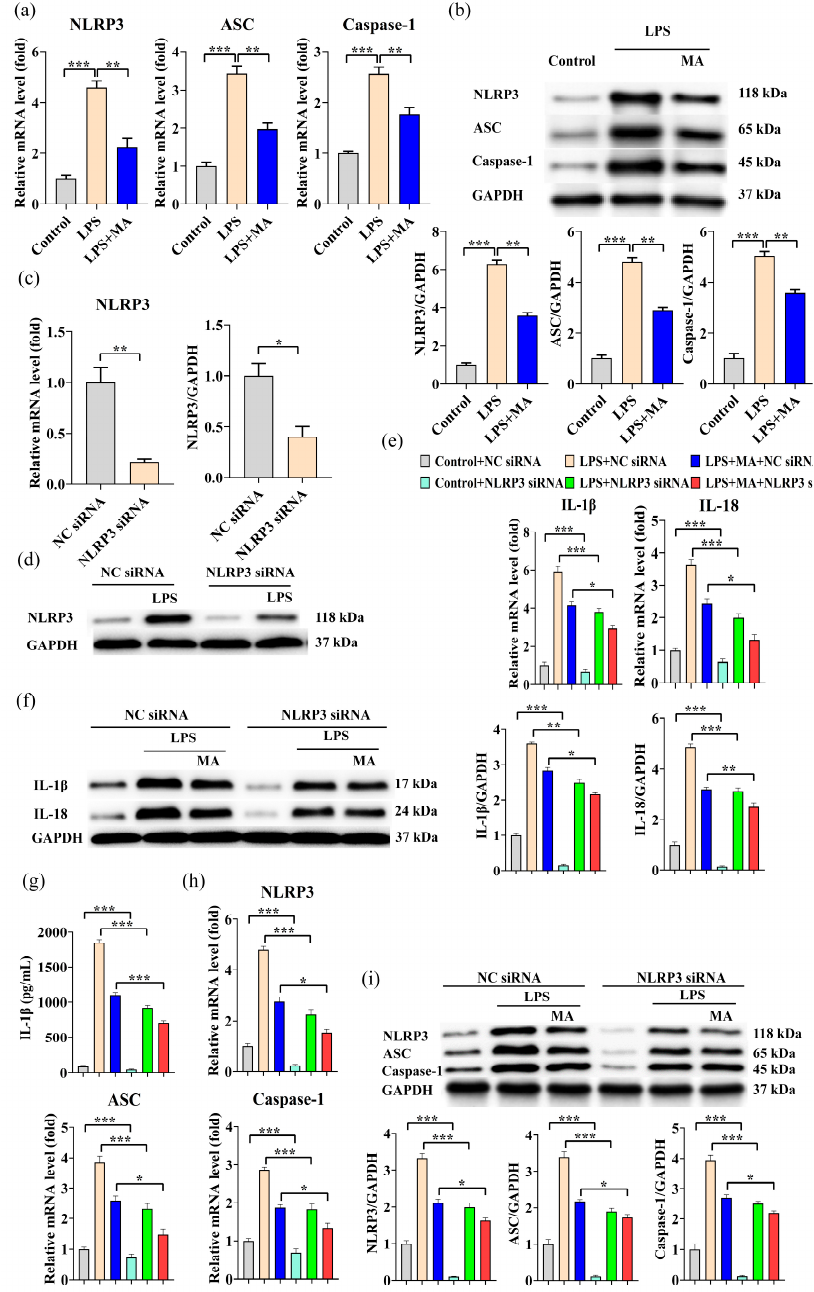
Figure 2. MA attenuates LPS-induced inflammatory effects through inhibition of NLRP3. ( a ) qRT-PCR was performed to evaluate the mRNA expression of NLRP3, ASC and Caspase-1 in RAW264.7